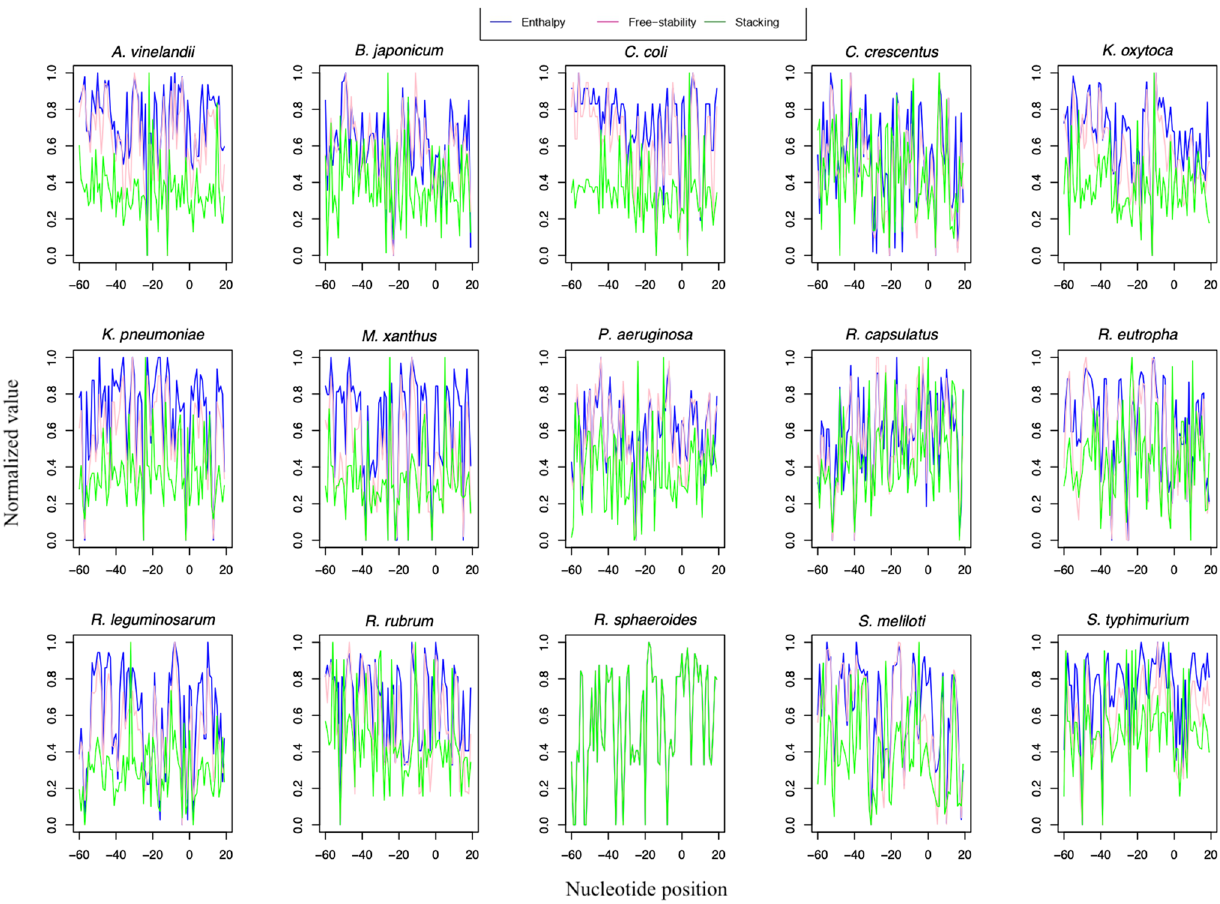
Fig. 3 Average values of enthalpy, free-stability, and base-pair stacking along the 80 nucleotides (− 60 to + 20) of σ 54 promoter sequences in 15 Gram-negative bacteria Table 3 Analysis of variance between promoter, shuffled, and cod- ing sequences Enthalpy